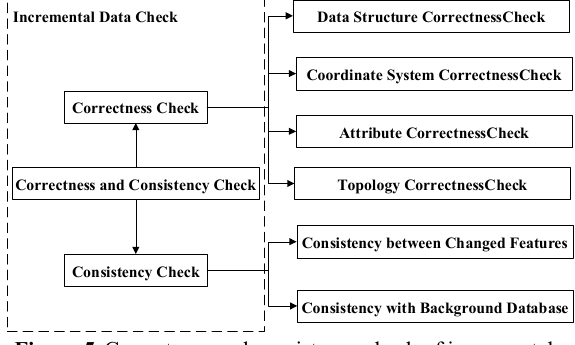
Figure 5 . Correctness and consistency check of incremental